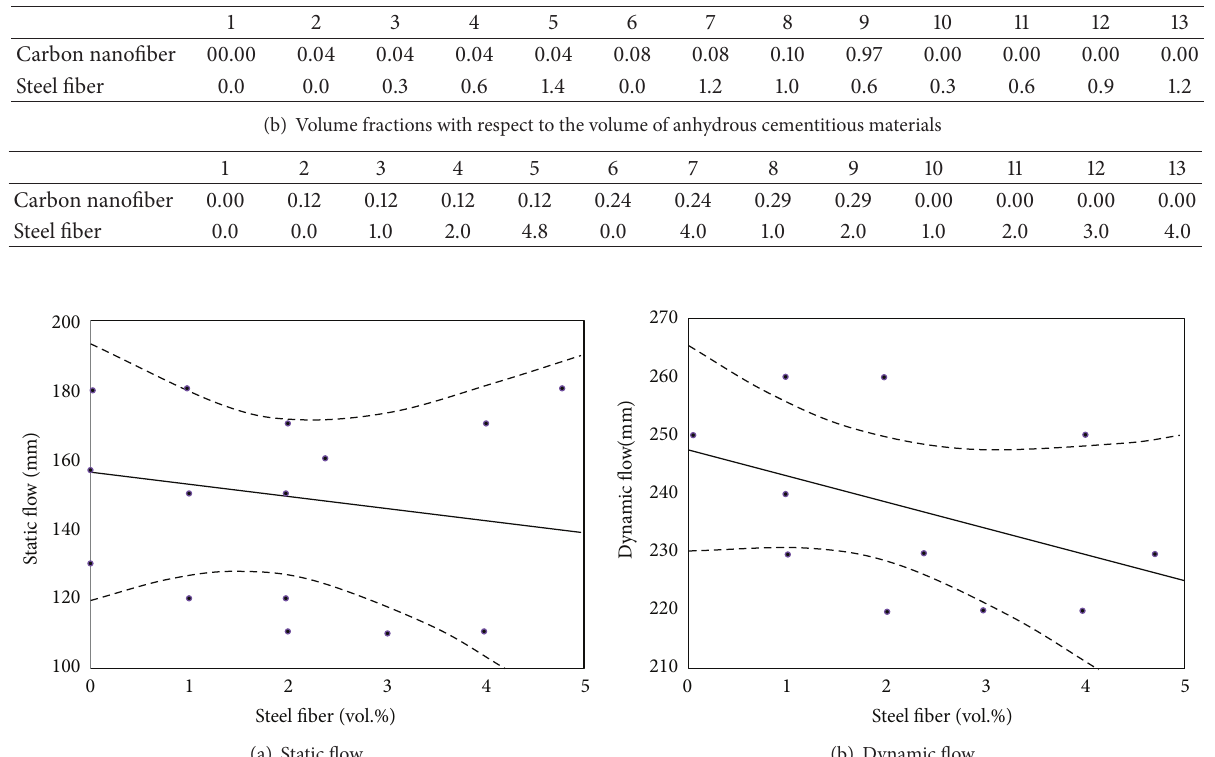
Figure 5: Effects of steel fiber volume fraction (with respect to anhydrous cementitious materials) on the static and dynamic flow of fresh mix (regression lines and 95% confidence intervals are shown; carbon nanofiber volume fraction